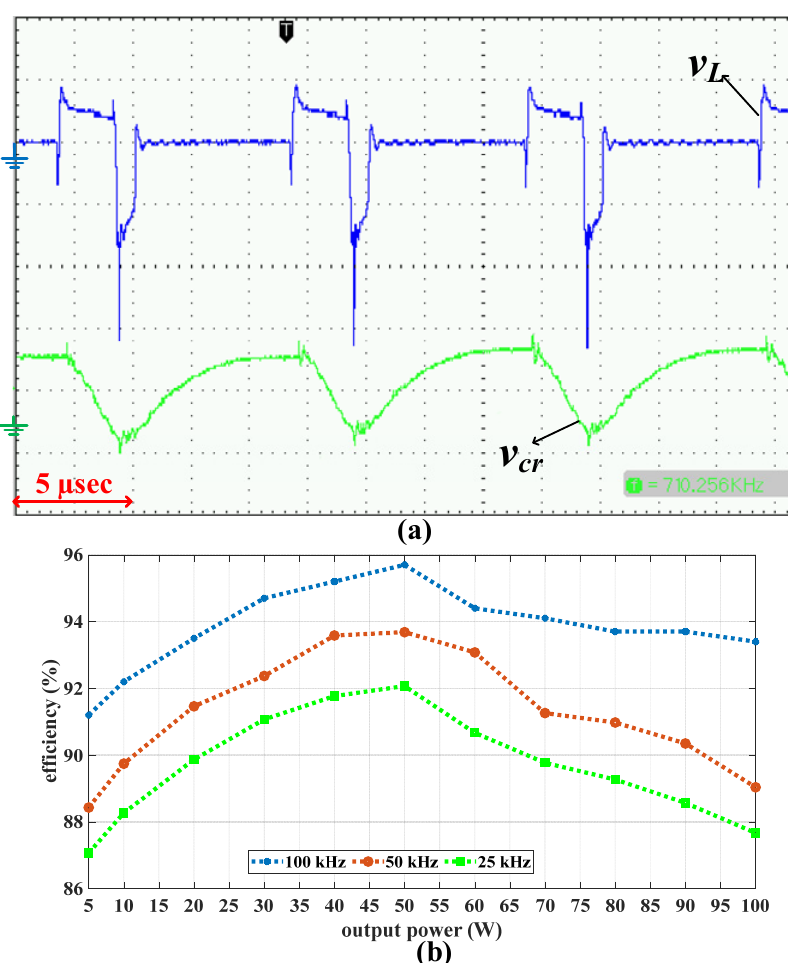
Figure 13. The simulation results showing the soft switching of the switches in the test conditions ( D = 0.2 and d = 0.45). ( a ) Q1 voltage and current; ( b ) Q2 voltage and current; ( c ) Q3 voltage and current.